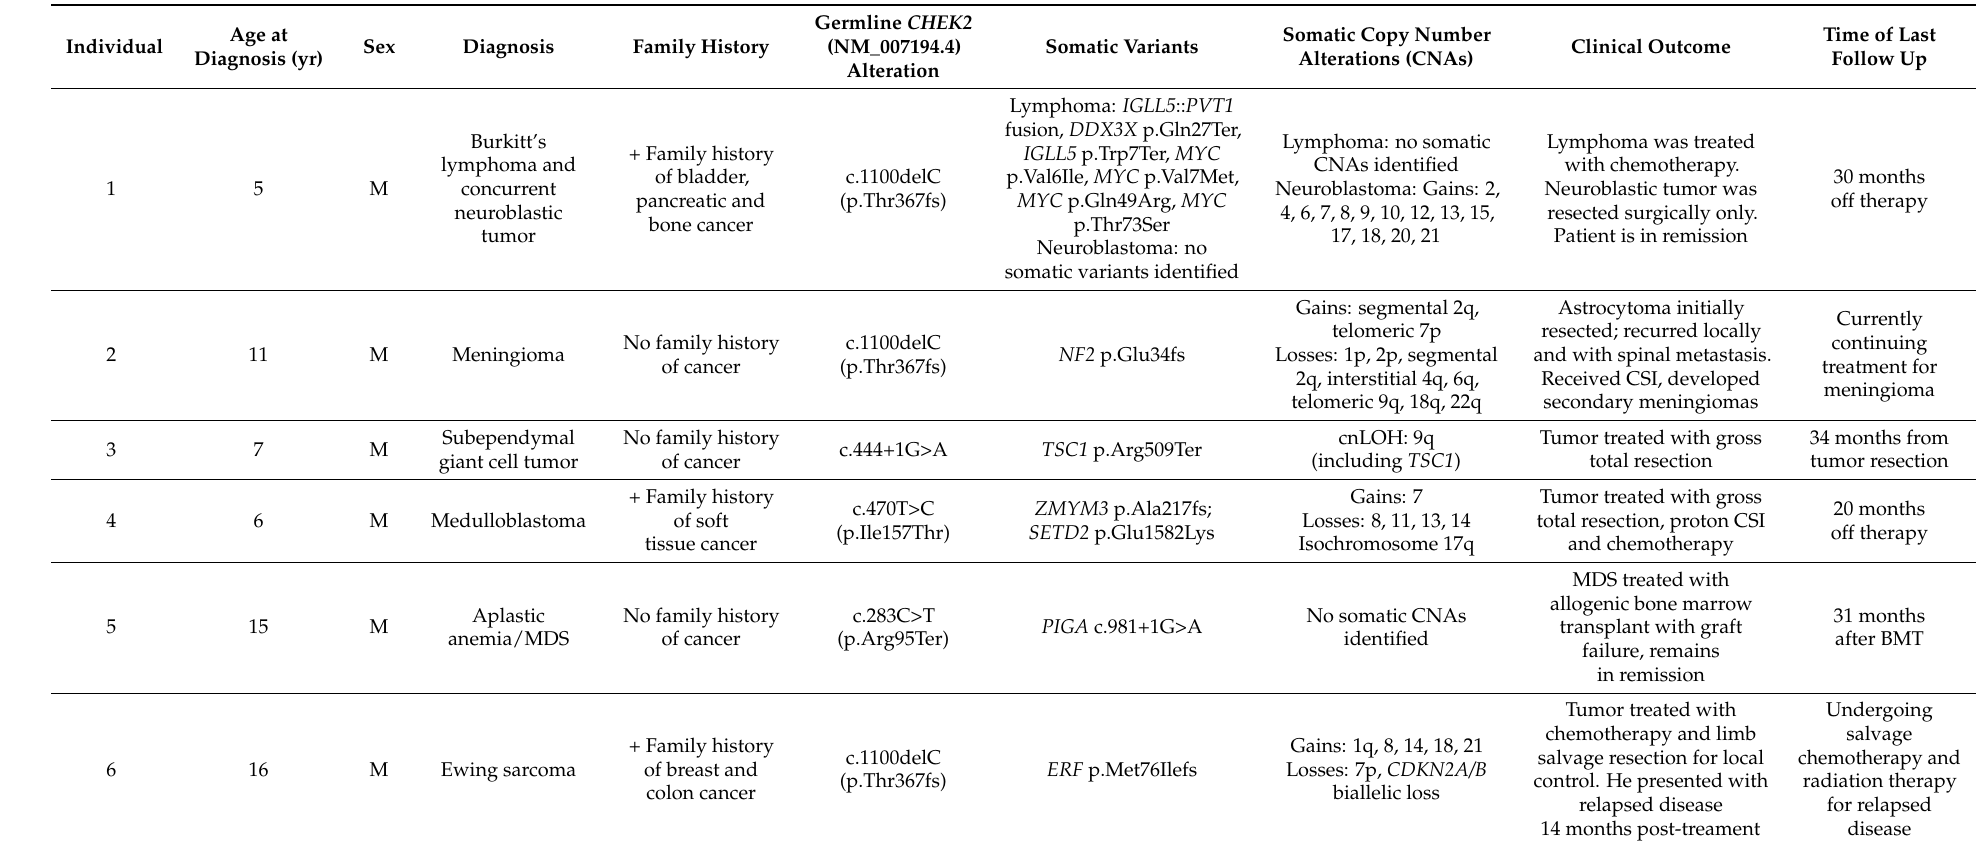
Table 1. Clinical and genomic findings of patients with CHEK2